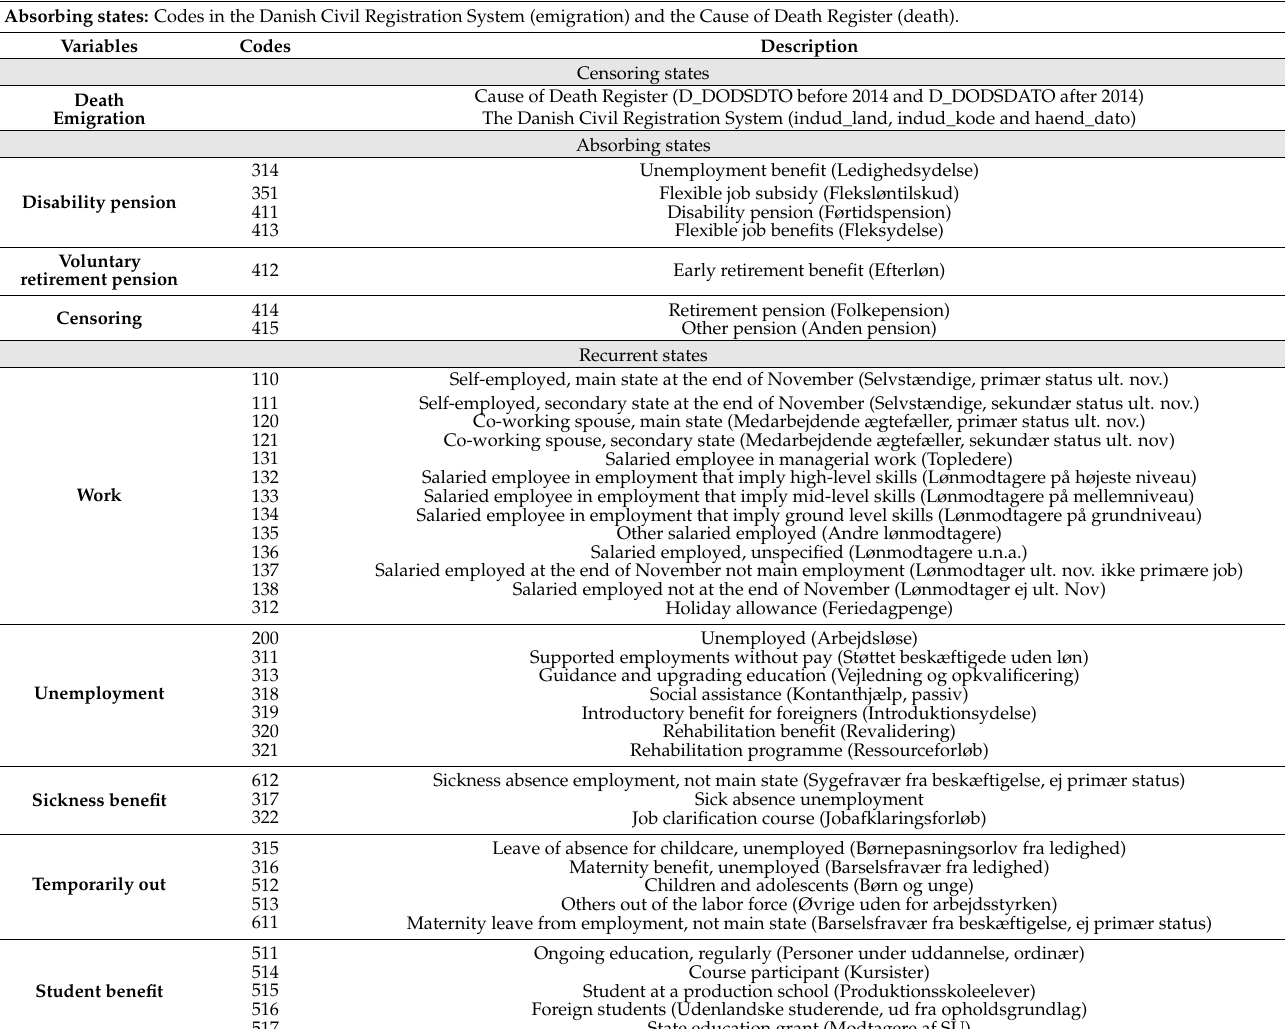
Table A1. Coding of labor market affiliations (outcome